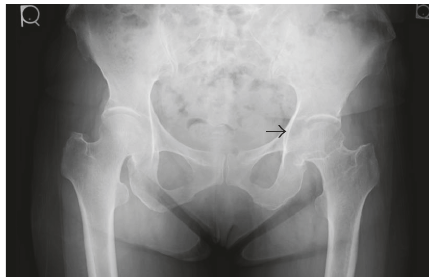
Figure 1: Anterior-posterior radiograph of the hip. Enlargement of the acetabular fossa is shown (black arrow).